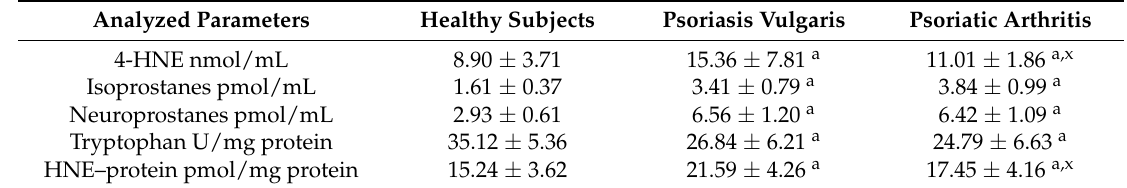
Table 3. The level of protein and phospholipid oxidative modification products in plasma from healthy subjects (n = 34) and patients with psoriasis vulgaris (n = 68) and psoriatic arthritis (n = 34).